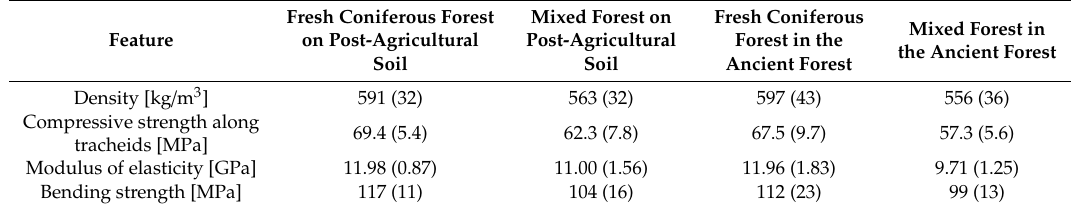
Table 6. Density and selected mechanical properties of wood from trees from four plots of the Chojn ó w Forest District (standard deviation is given in parentheses).